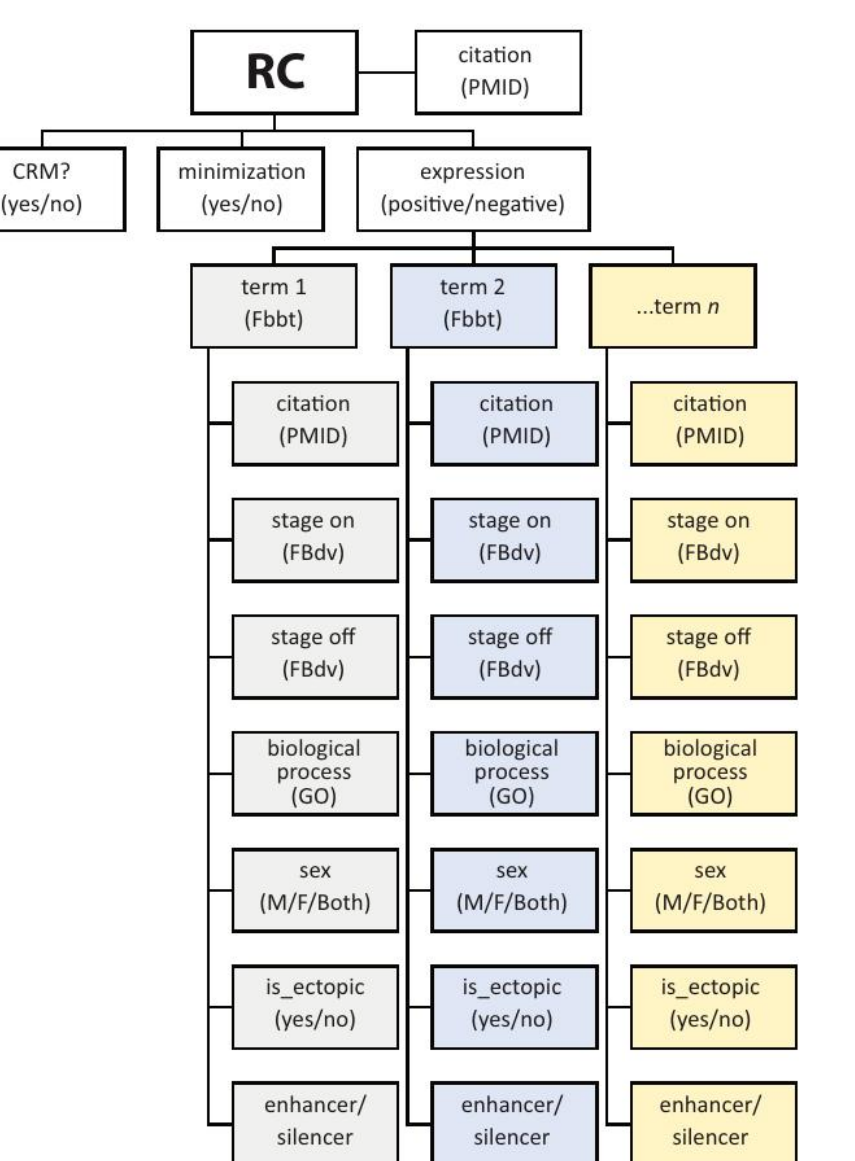
Figure 2. The basic REDfly Reporter Construct data model. Depicted is a partial illustration of the data model for REDfly Reporter Construct (RC) records. Each RC has the three basic attributes of CRM , minimization , and expression . If expression is positive, the RC is annotated with each anatomical location where expression is observed, to the most granular degree available, based on a species- relevant anatomy ontology. Each annotated expression pattern is then associated with additional data including citation; the stages at which expression is observed; a biological process (where relevant) drawn from the Gene Ontology; the sex in which the expression is observed; whether or not the expression is ectopic with respect to the known pattern of the associated gene; and whether the RC is acting as an enhancer or a silencer in the current tissue. Not included in the schematic are additional RC-associated data such as species, gene names, relevant figure panels, evidence terms, and